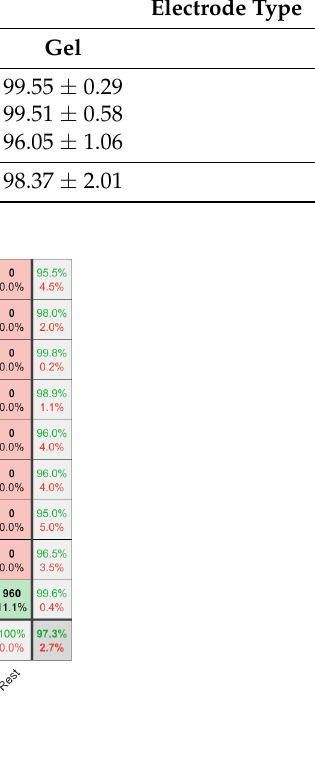
Table 2. Percentage classification accuracies of models trained on individual subject data for the recognition of nine gestures. Results are mean ± standard deviation over ten folds.